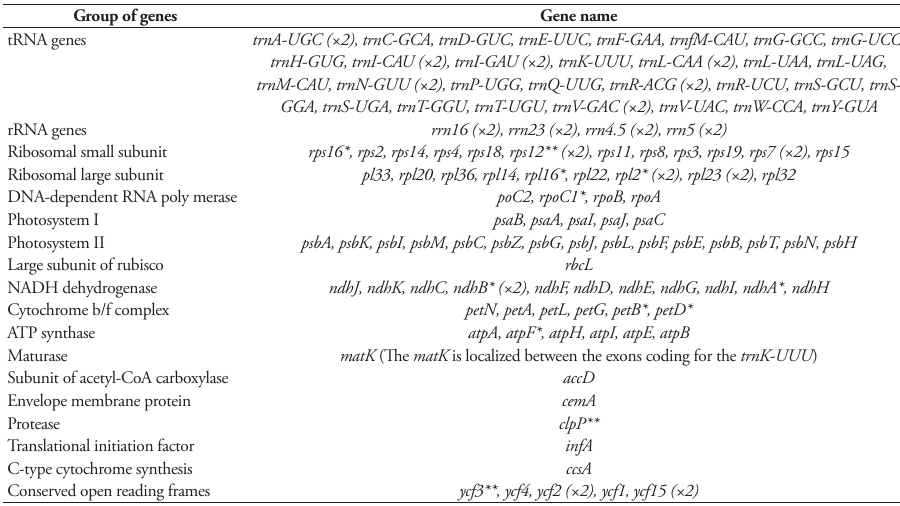
Table 2. Genes encoded in plastid genome of Pilea danxiaensis .